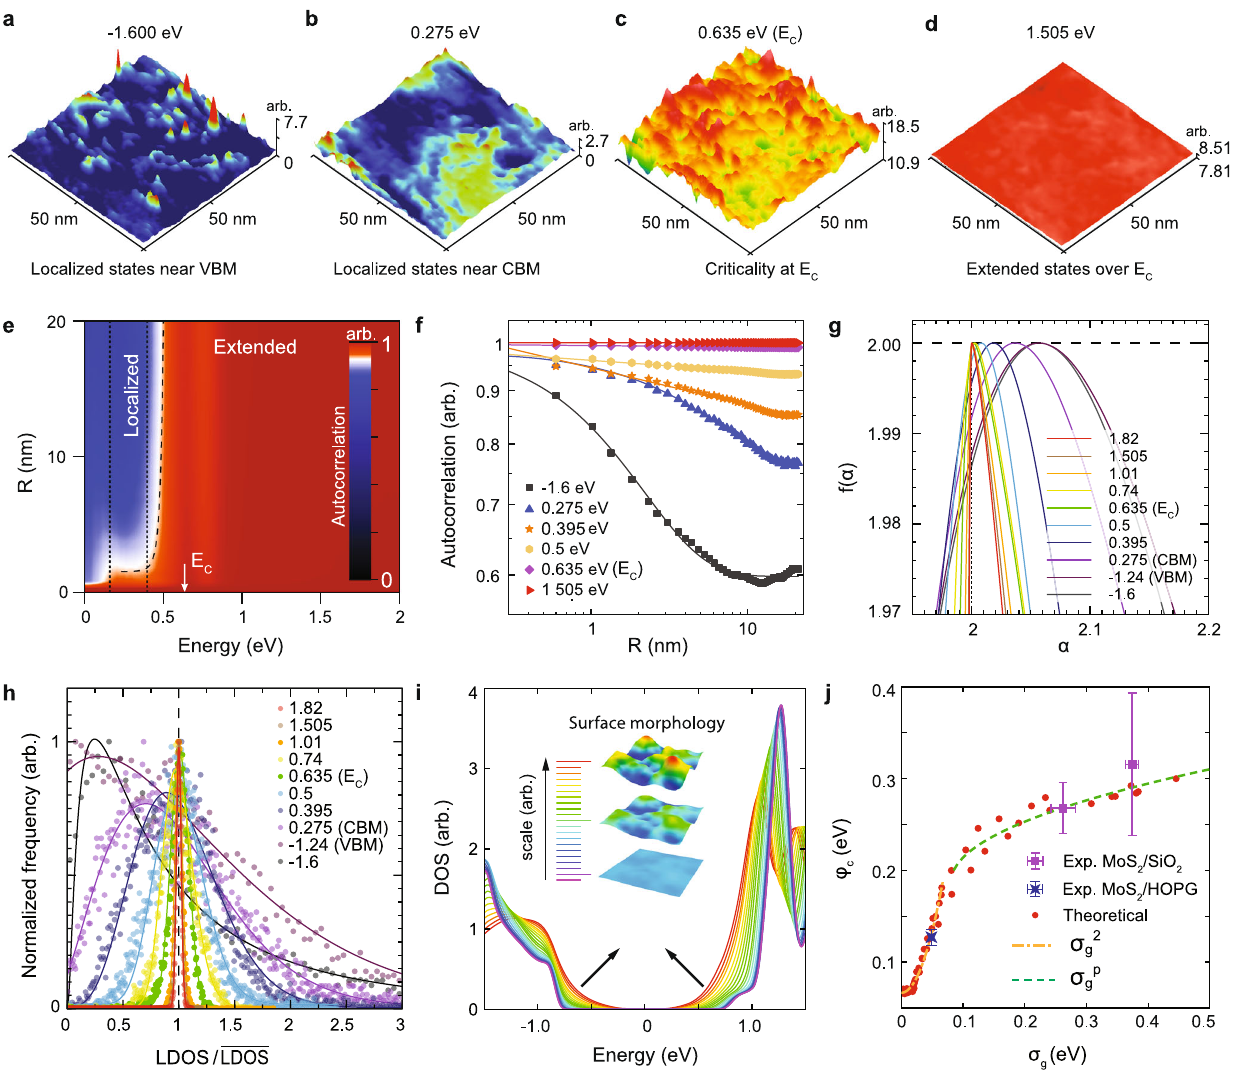
Fig. 4 | Criticality of metal – insulator transition and band tails in structurally disordered monolayer MoS2. a – d STS maps of the electron-doped MoS 2 (data fromFig.1j)near( a )VBM,( b )CBM,( c )atthe criticalenergy( E C ), and ( d )abovethe critical energy. e Autocorrelation of the STS results in the electron-doped MoS 2 (data from Fig. 1j). The interval between the dotted lines indicates the fl uctuation range of the local conduction band edges. The critical energy ( E C ) is indicated by the arrow. The dashed line is ~ ( E C – E ) − ν , following the contour of the auto- correlation. The Fermi level is set to zero. f , Line pro fi les of the autocorrelation at different energies. The colored lines are fi tted lines using the power law or expo- nential function. g Multifractal spectra and h , histograms of normalized LDOS at different energies. i Exponential band tails near the band edges, calculated by the